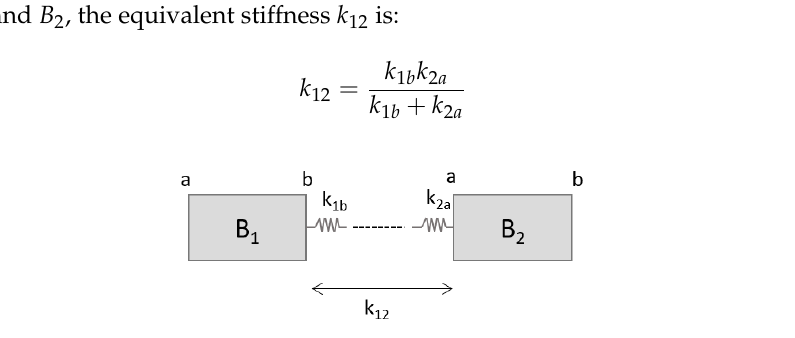
Figure 1. Two rigid bodies connected through elastic elements. a and b are the two faces of each body where the connections are. k 12 is the total stiffness matrix given by the interaction of both elastic forces from faces B 1 b and B 2 a